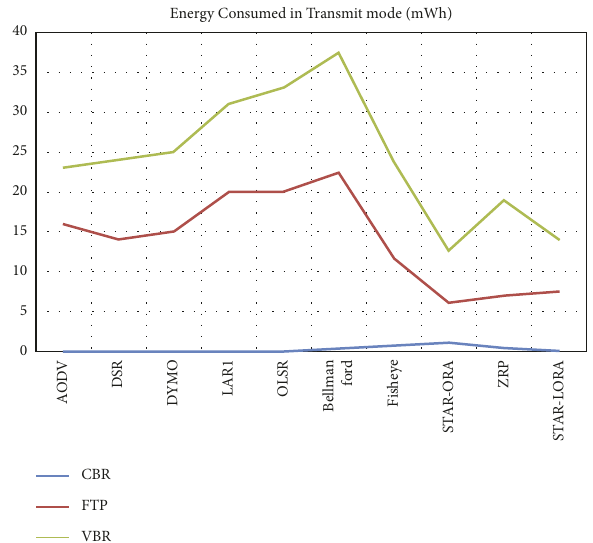
Figure 29: Energy consumed in transmit mode of all routing protocols in CBR, FTP, and VBR